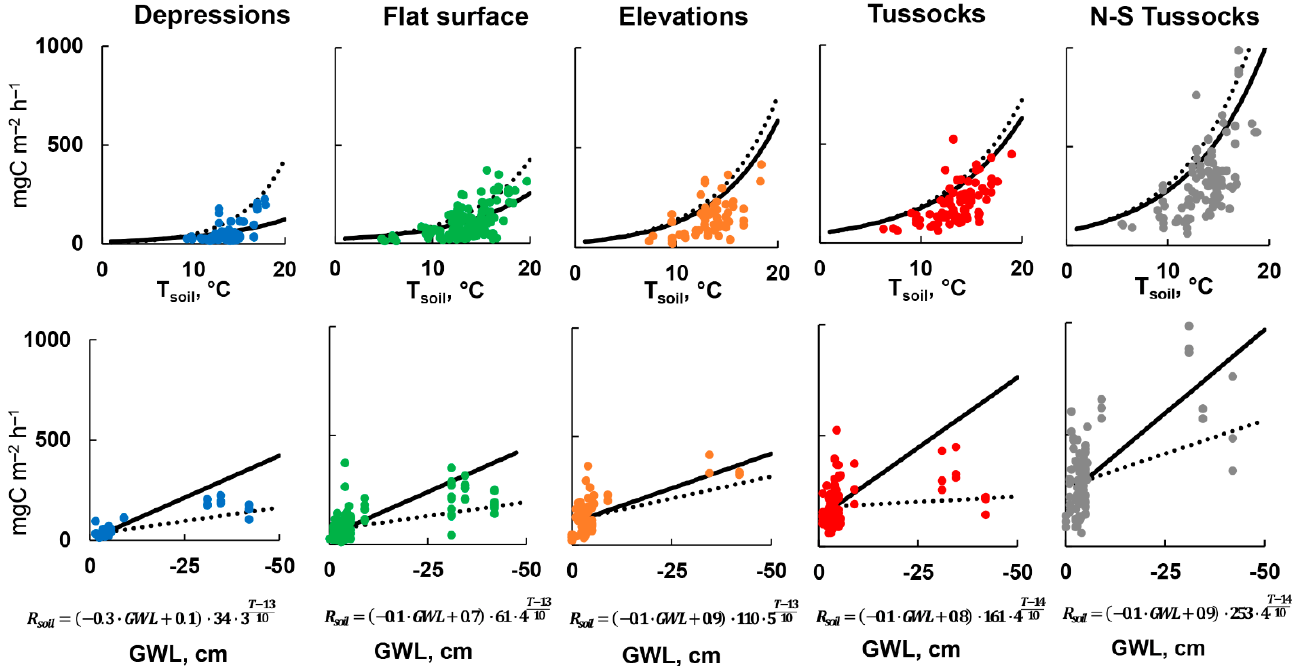
Figure 8. Differences in R soil model parameterization, including (dotted line) and excluding (solid line) extra dry periods.